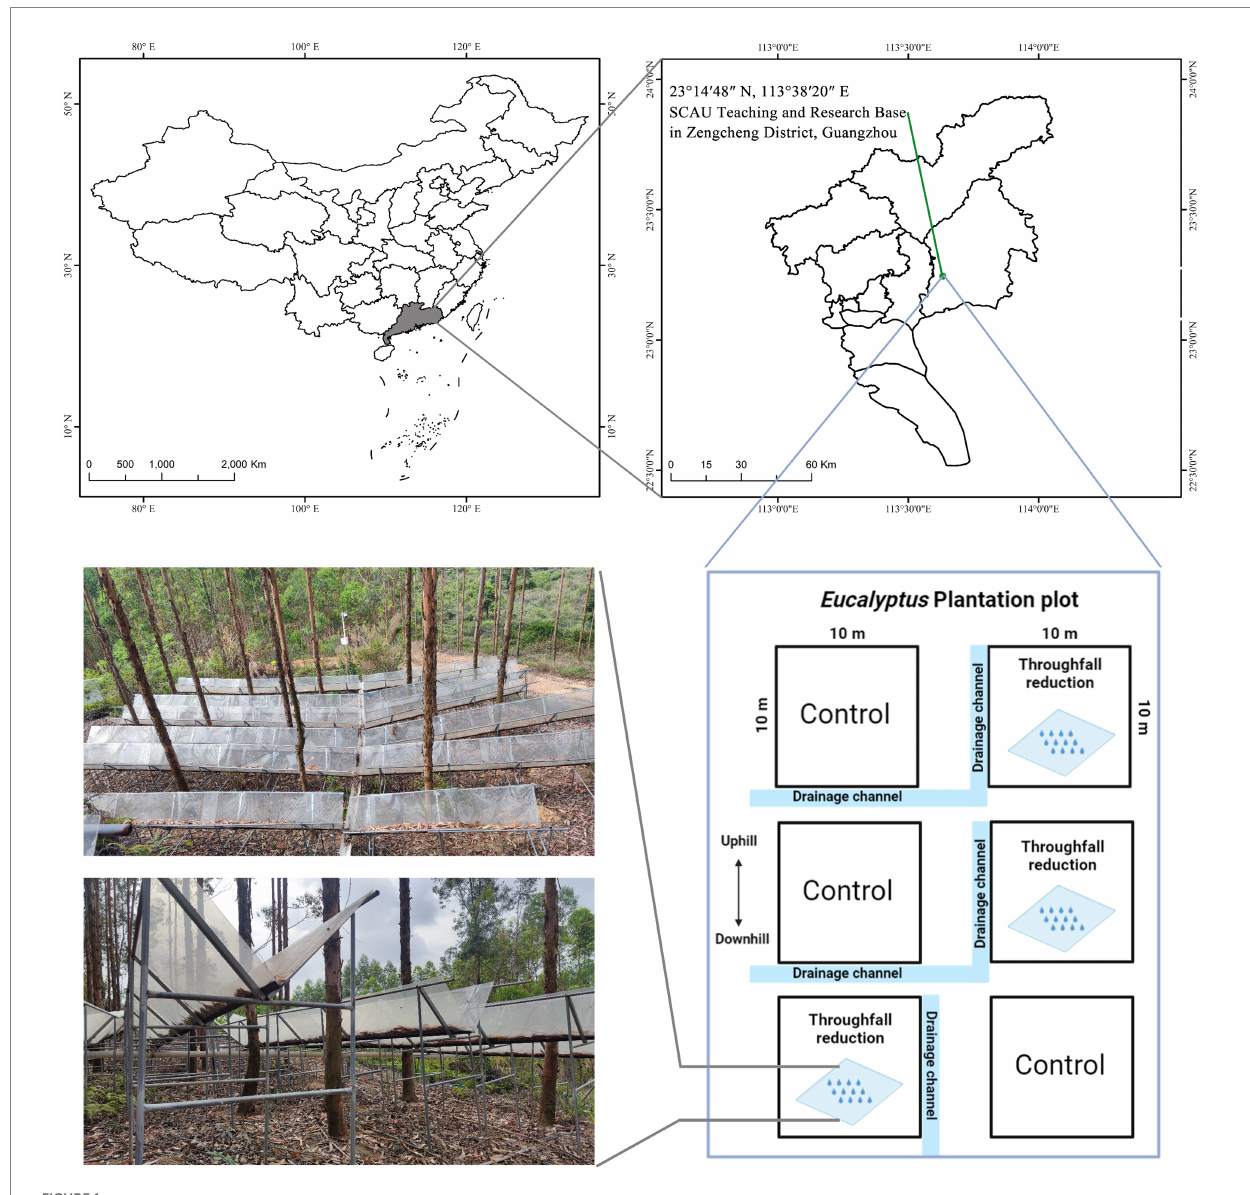
FIGURE 1 Study area and sampling sites in the Zengcheng district, Guangdong Province of